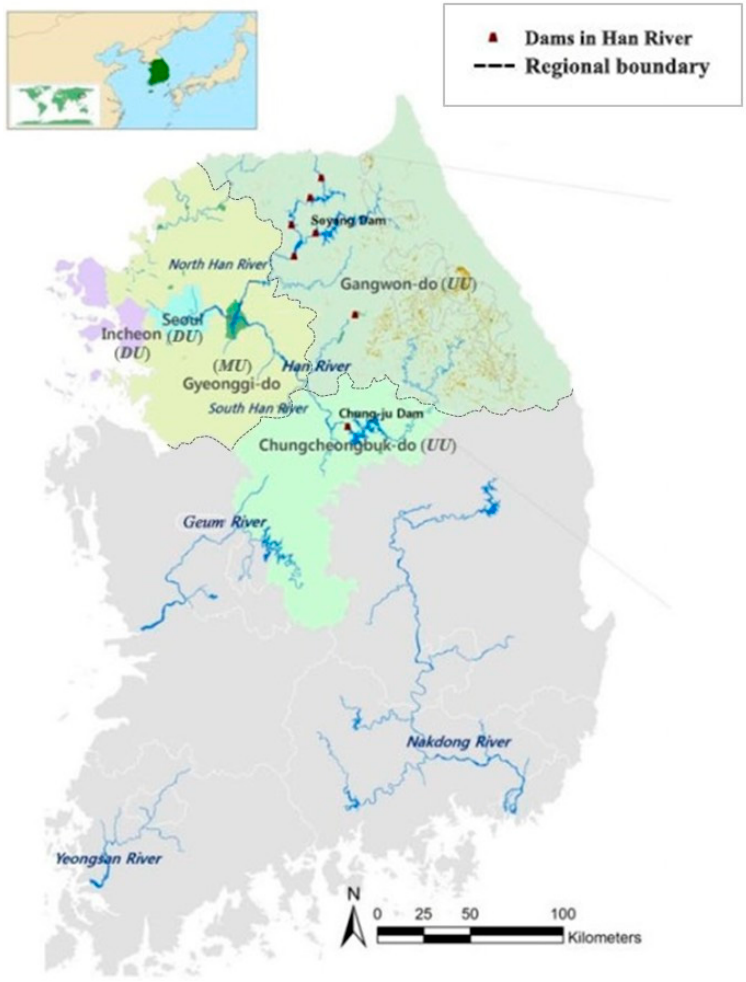
Figure 1. The Han River Basin, study area.